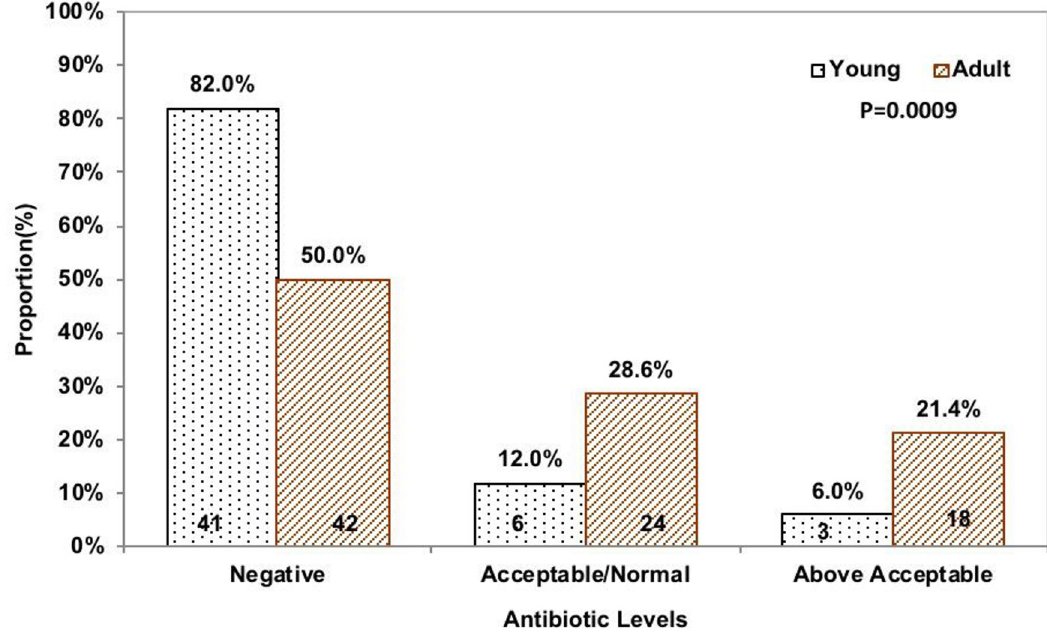
Fig 2. Beta-lactam levels by age (beef carcass counts are at the bottom of bars).